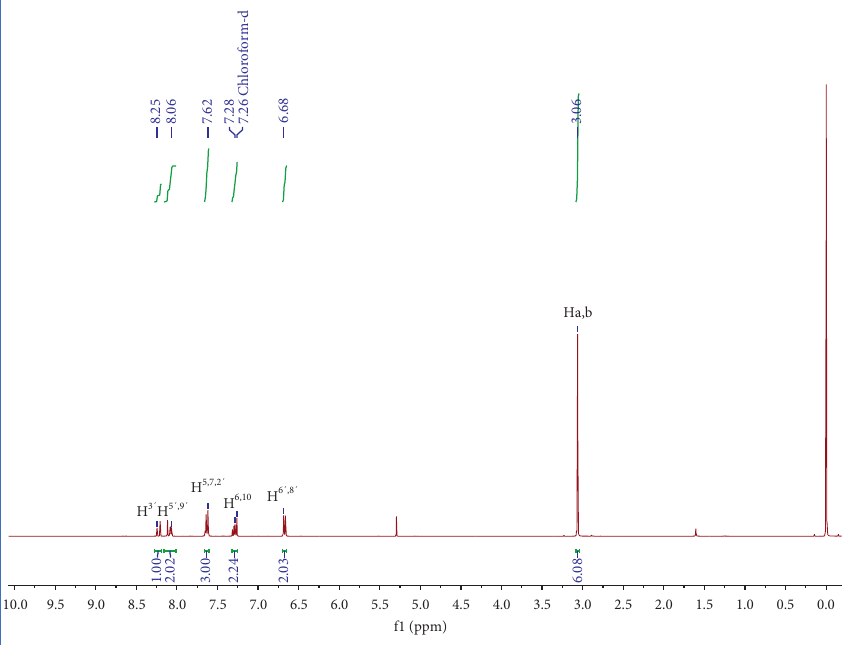
Figure 2: 1 H NMR spectrum (400 MHz, CDCl